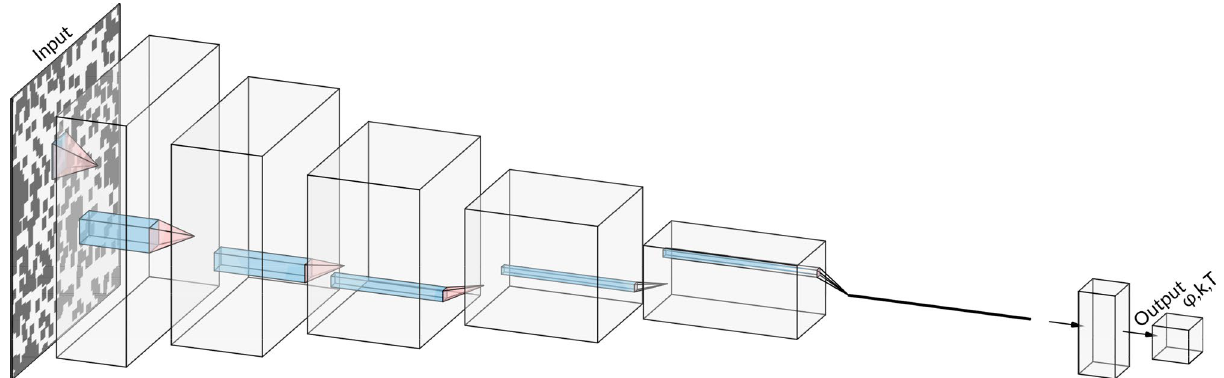
Figure 4. The network net A architecture. It contains six convolutional blocks and two (including output) fully connected layers. Each convolutional block contains the max pooling layer. The first three convolutional blocks consist of the batch normalization layers. The graph was drawn using NN-SVG 46